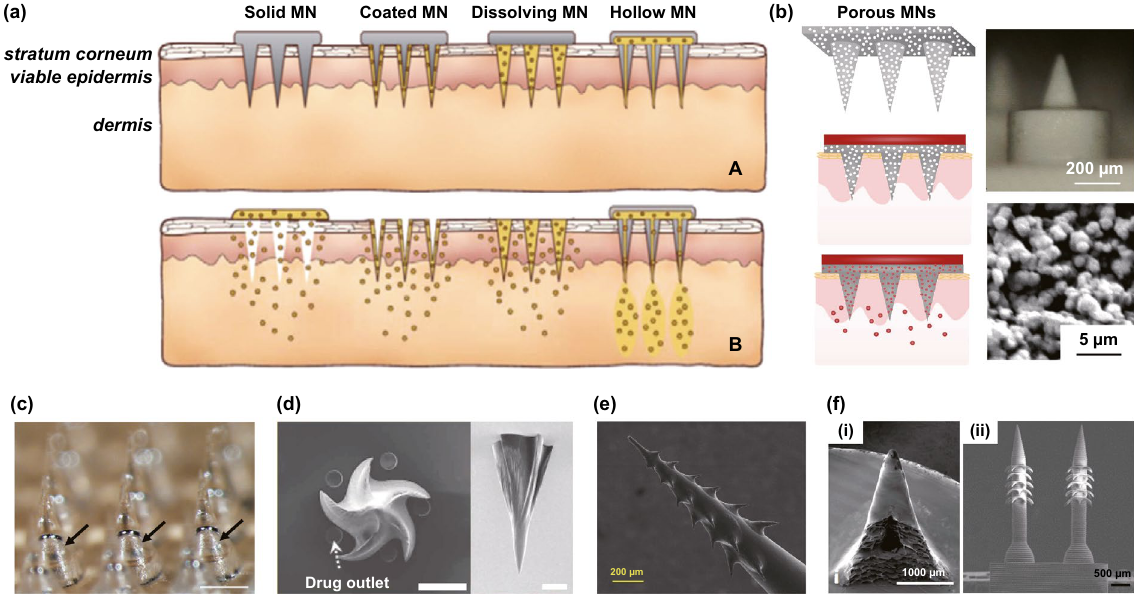
Fig. 9 a Transdermal drug delivery strategies using microneedles: (A) Various types of microneedles apply to the skin, and (B) correspond‑ ing methods used for drug delivery [200]. b Drug delivery strategy (left column) and SEM images (right column) of porous microneedles [201, 202]. c–f Micrographs of representative novel physical forms of microneedles, including c rapidly separable microneedles (scale bar: 500 μm) [204]. d grooved microneedles (left: top view, right: lateral view. scale bar: 100 μm) [205]. e magnetorheological lithographed microneedles [209]. f 3D printed microneedles with internal hollow (i, [7, 212]) and with backward‑facing barbs (ii, [12, 213]). Reproduced with